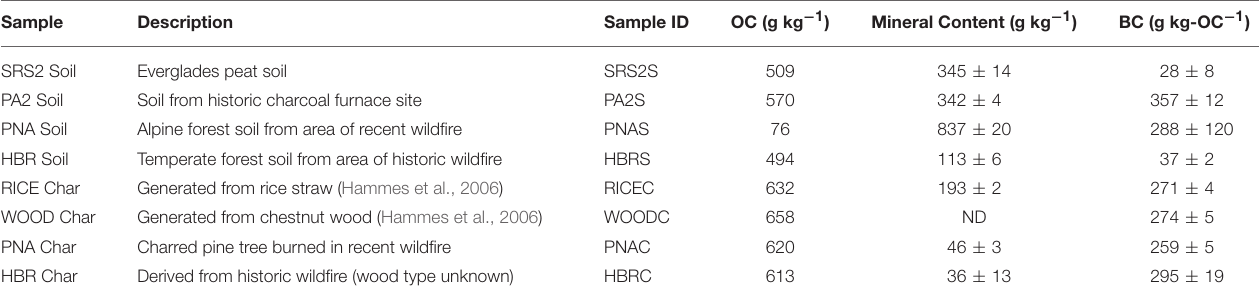
TABLE 3 | Characterization of soil and char samples. Sample